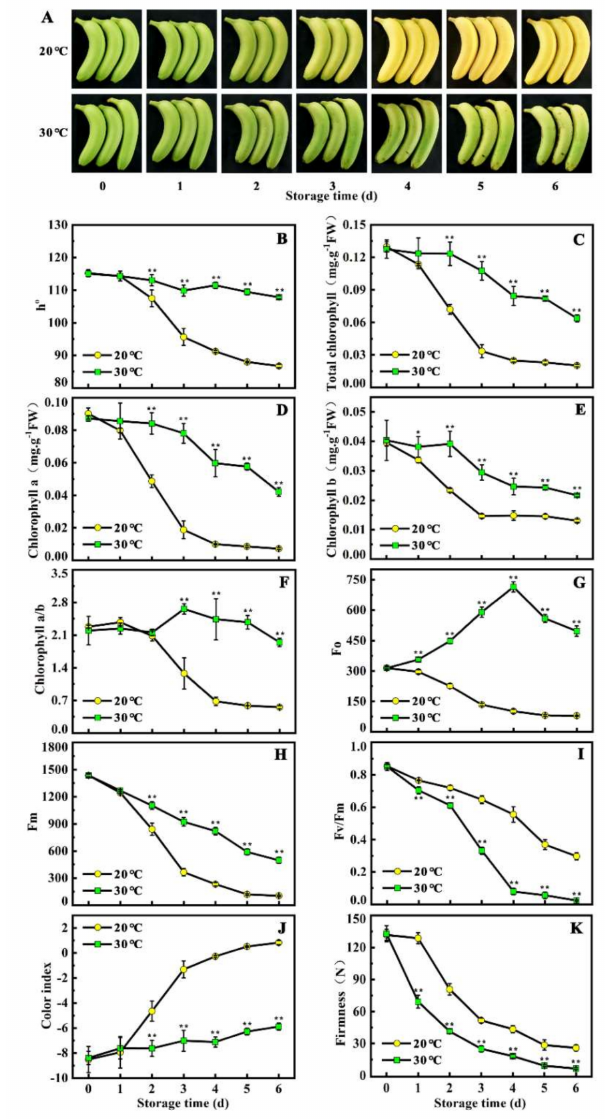
Figure 1. High temperature induces stay-green ripening in banana fruit. ( A ) Appearance of ripening fruit stored at 20 ◦ C (control) and 30 ◦ C (high temperature). ( B – K ) Changes of h ◦ , total chlorophyll content, chlorophyll a, chlorophyll b, chlorophyll a / b, Fo, Fv, Fm, Fv / Fm, color index, and fruit firmness in fruit stored at 20 ◦ C and 30 ◦ C during ripening. Fruit is pre-treated with 100 µ L / L ethylene for 18 h at 20 ◦ C, and, subsequently, stored at 20 ◦ C and 30 ◦ C for six days, respectively. Data are the mean ± S.E. of three biological replicates. Asterisks indicate significant di ff erences by a student’s t -test (* p < 0.05, ** p <